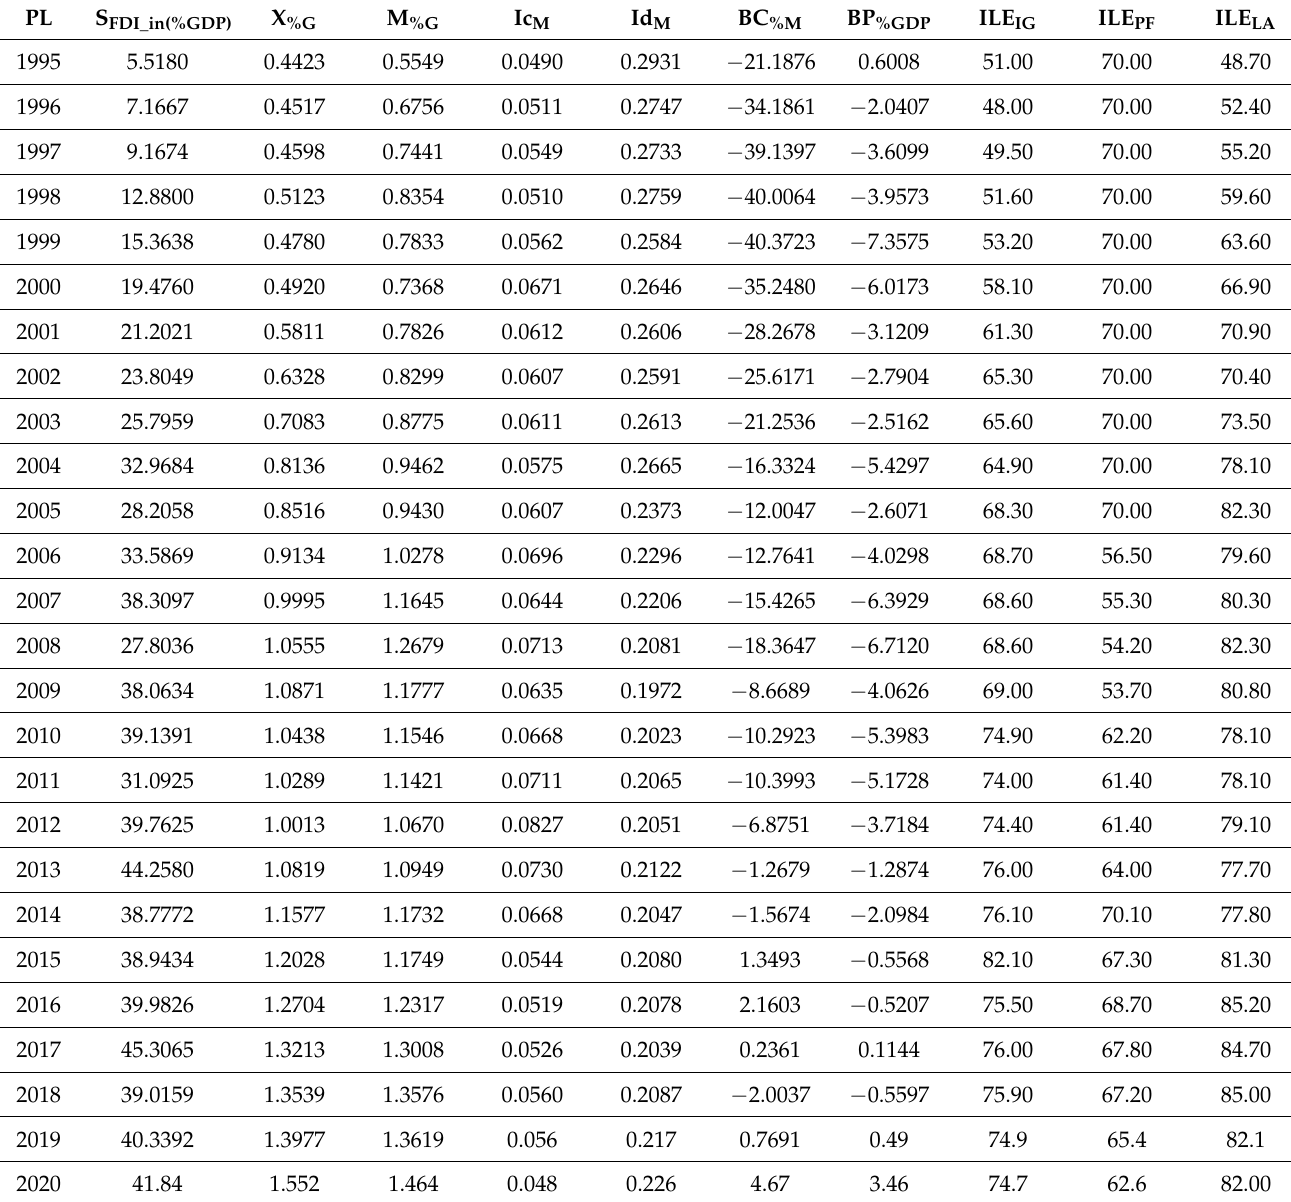
Table A3. Values of economic indicators for